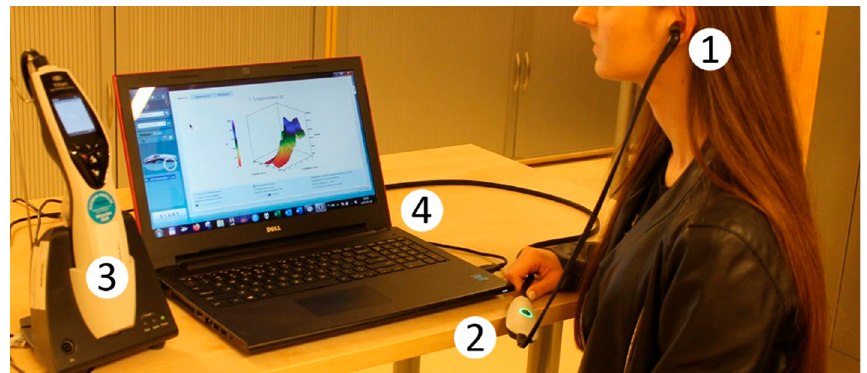
Figure 1. Measuring set-up for absorbance tests with Titan IMP440/WBT440 system. 1 — Probe: presentation of stimuli and recording of acoustic signals from the ear canal; 2 — Pre-amplifier with